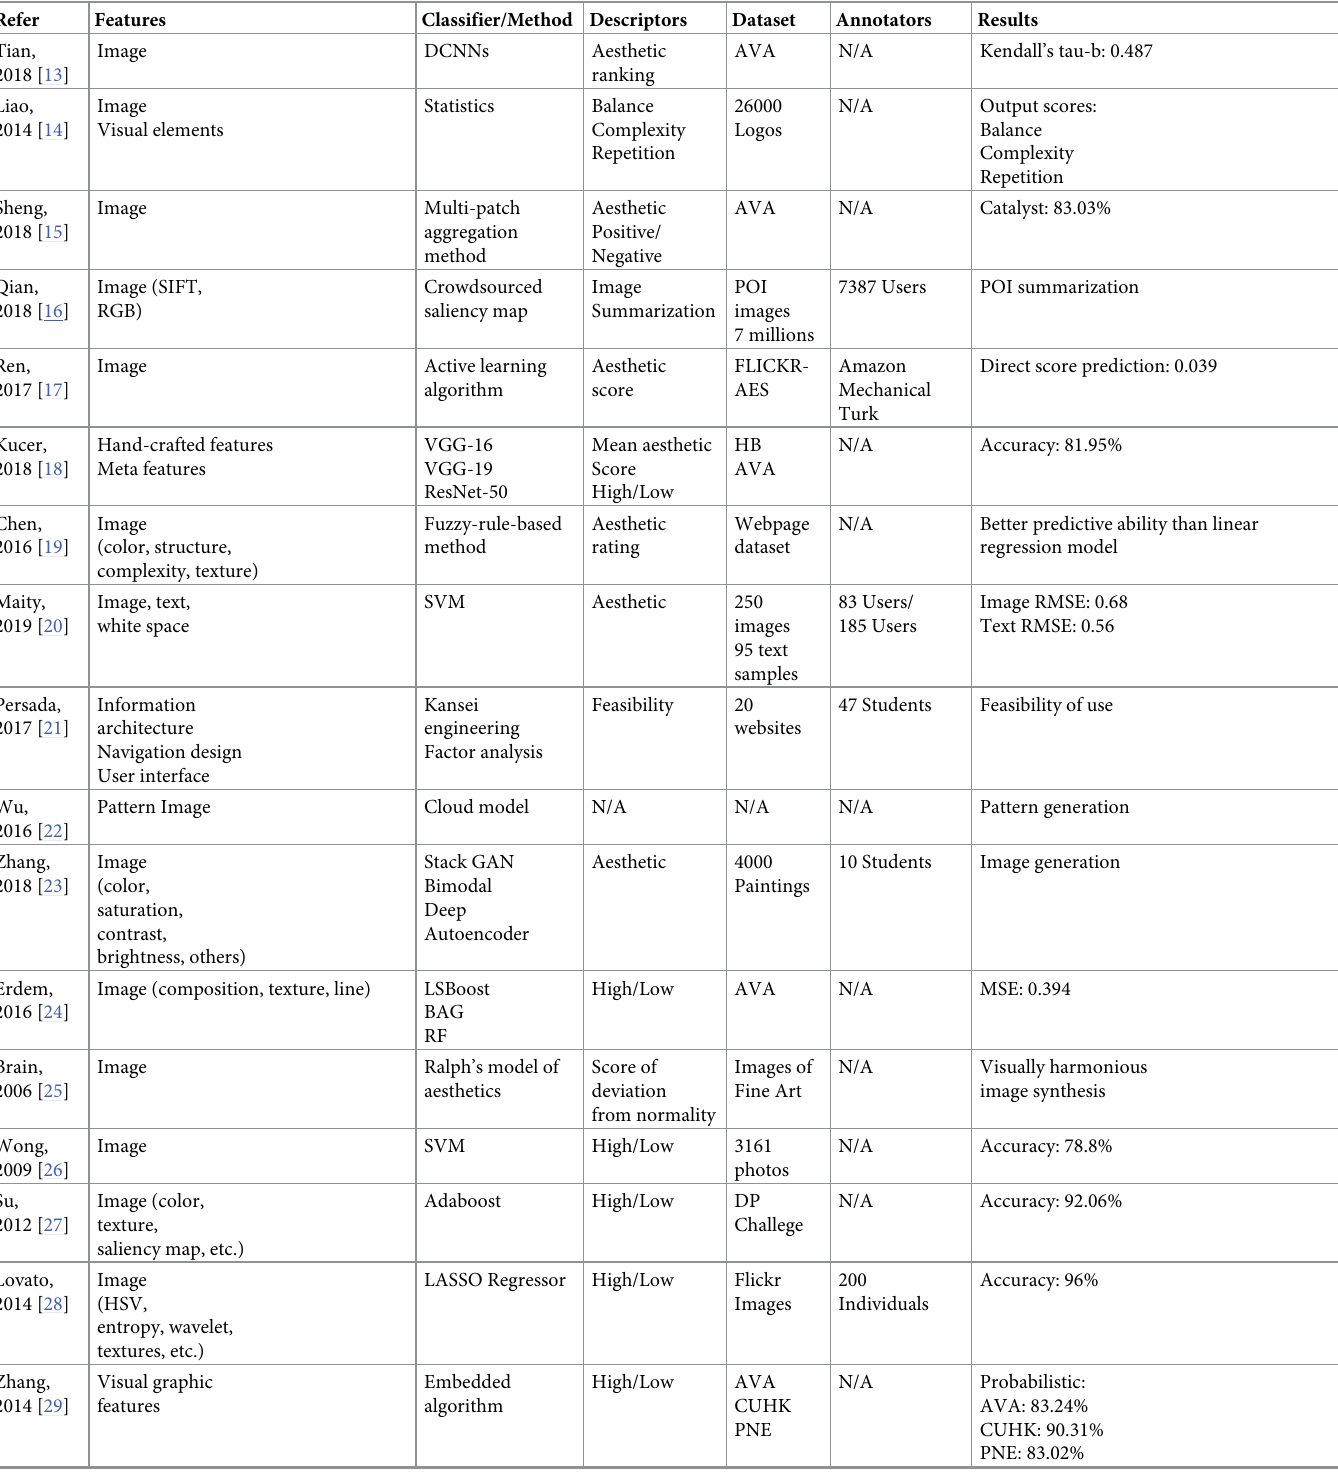
Table 1. Multimedia aesthetic-aware modeling